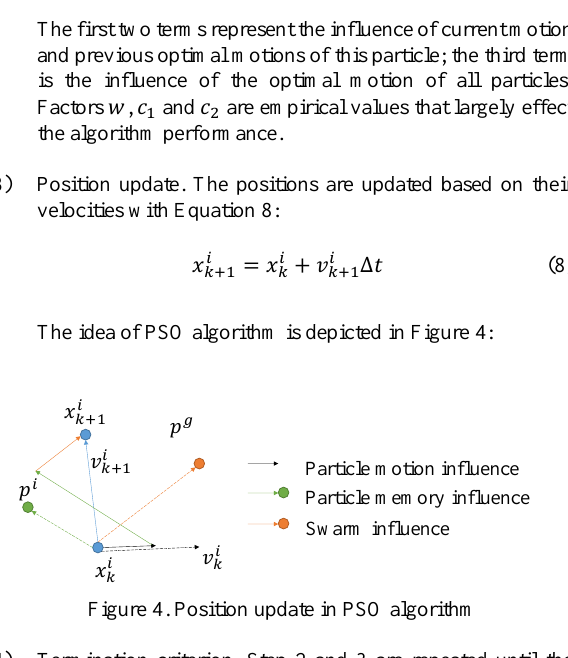
Figure 4. Position update in PSO algorithm